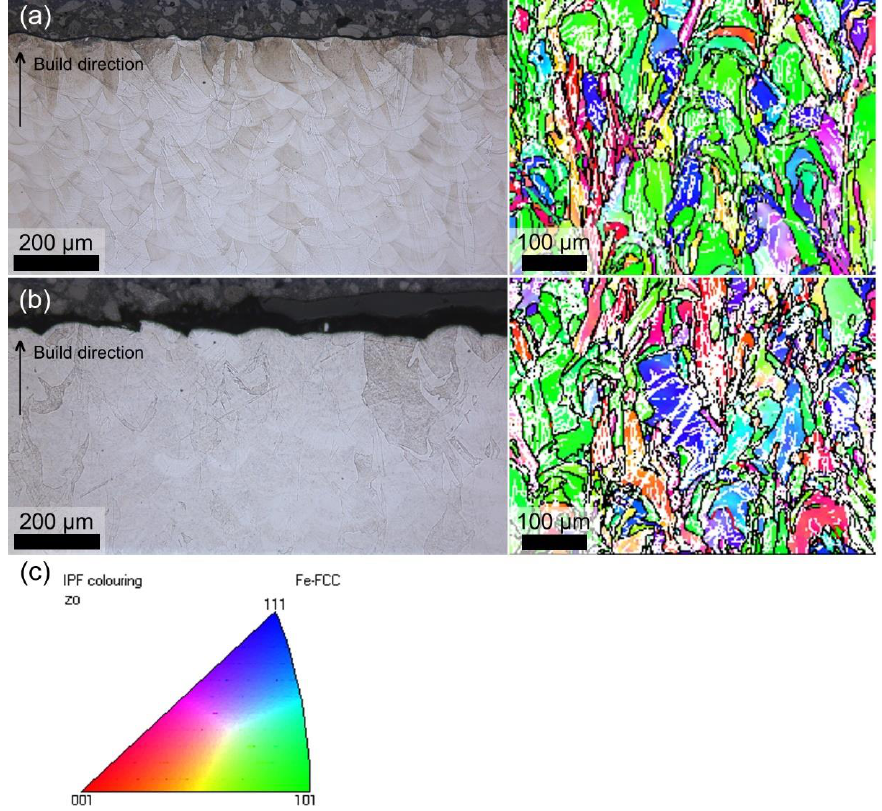
Figure 3. Optical microscope image from surface (left) and inverse pole figure (IPF) map superimposed on band contrast (BC) map from bulk (right) for ( a ) AsB AM sample and ( b ) AsB HT AM sample. The colors in the IPF maps correspond to the orientations (z direction), as indicated by ( c ) IPF coloring key for austenite (iron face-centered cubic structure, Fe-FCC). In IPF + BC maps, low-angle boundaries (2–10°) are marked by white lines and high-angle boundaries (>10°) by black lines.